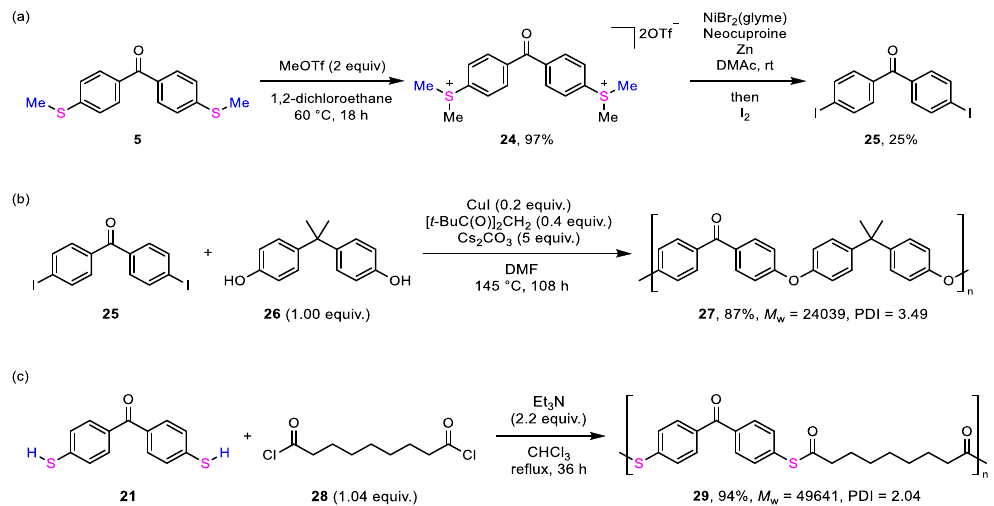
Fig. 6 Utility of products. a Transformation of 4,4 ′ -di(methylthio)benzophenone ( 5 ) to benzophenone 4,4 ′ -bis(dimethylsulfonium) salt 24 followed